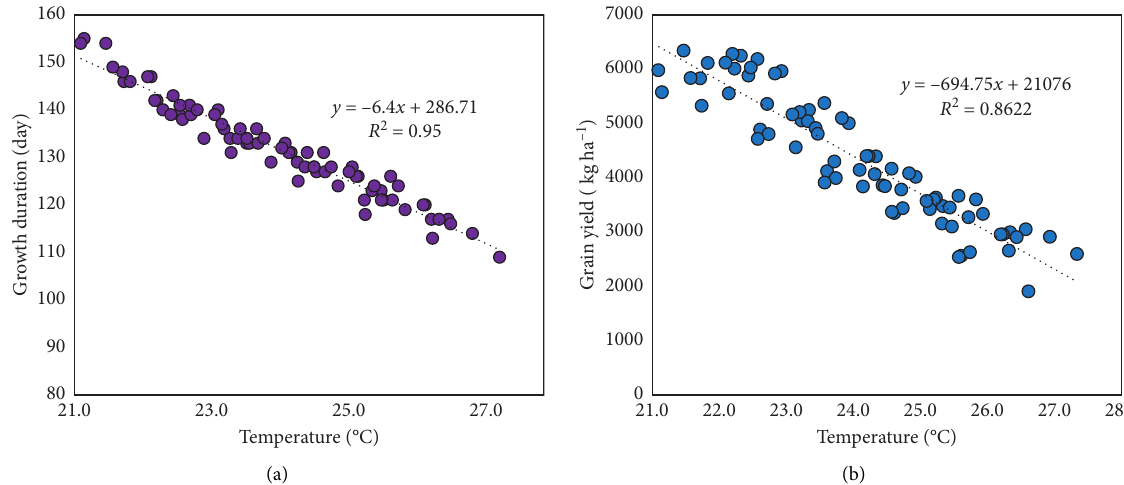
Figure 3: Interrelationship among seasonal mean temperature, growth duration, and grain yield for Boro rice in Bangladesh.